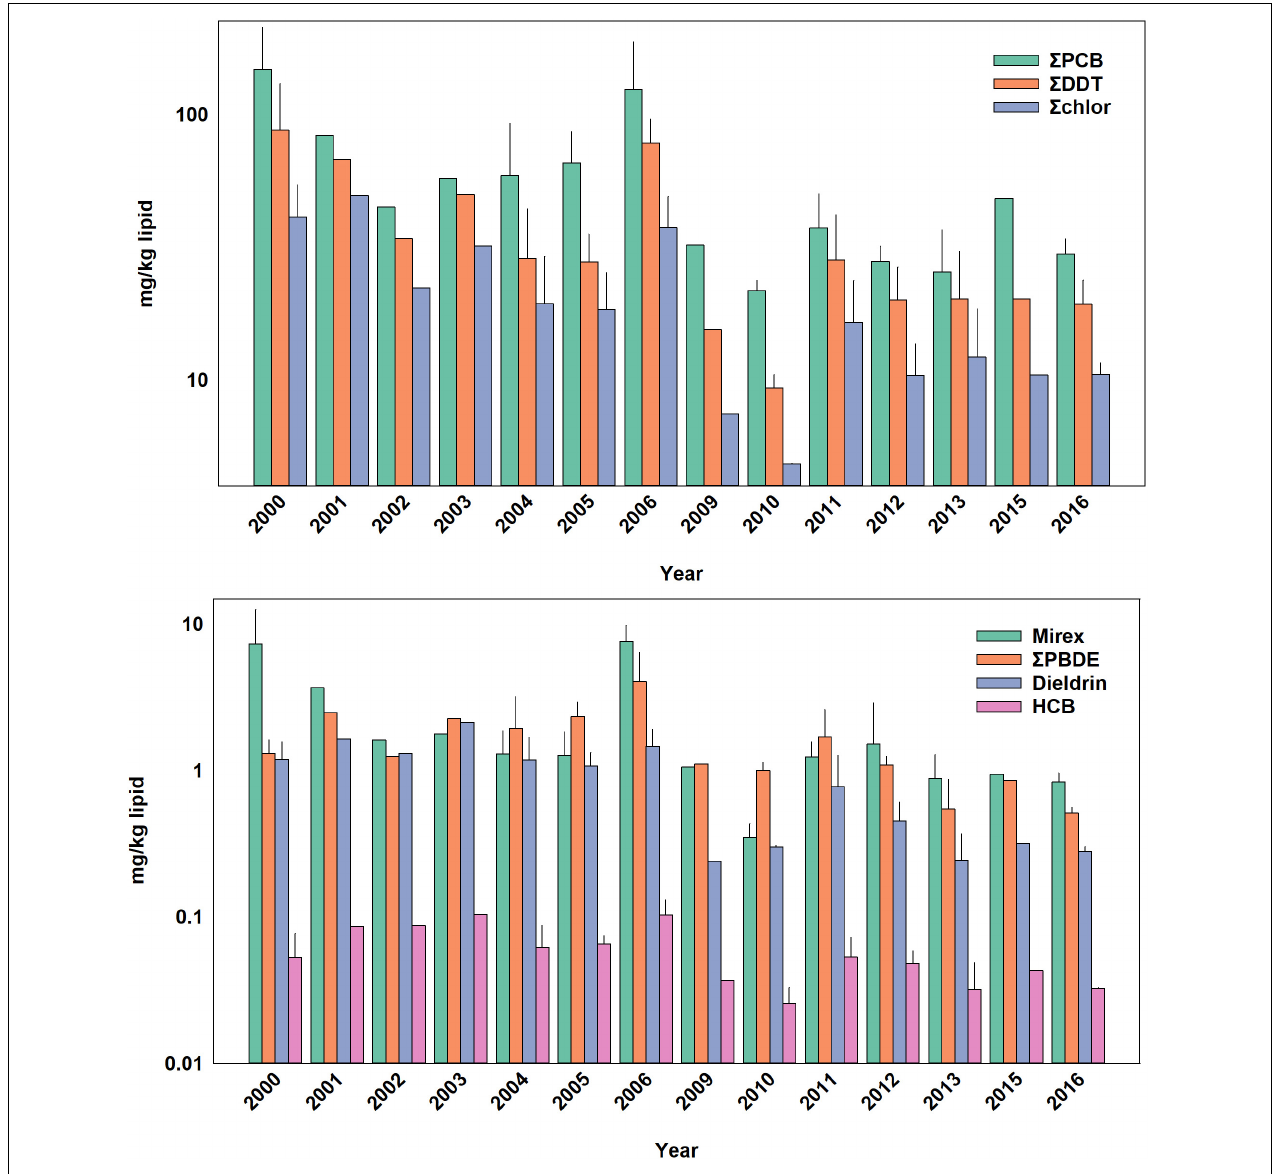
FIGURE 2 | Temporal trends of POPs in adult male bottlenose dolphins. Bars are mean ± standard deviation. Values in parentheses are for error bars that are off